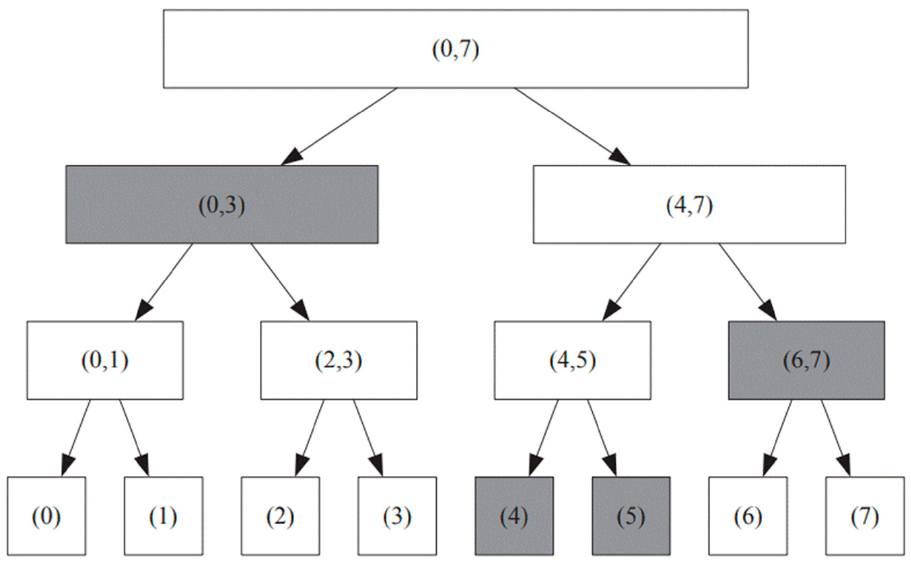
Figure 9. A sample binary search tree for partition selection used for AHWT (N = 16).